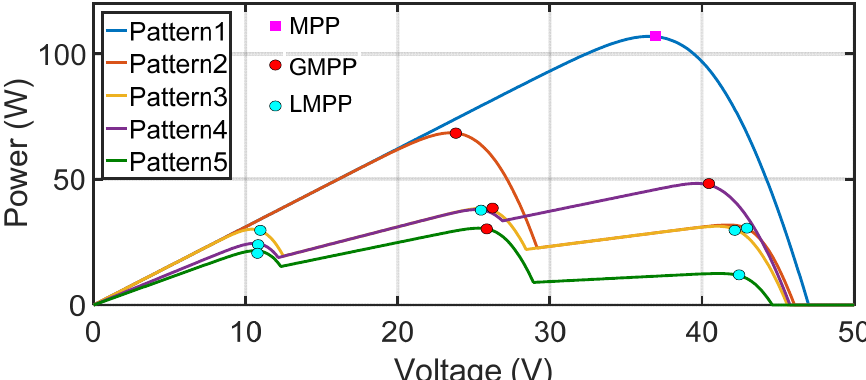
Figure 5. The P ‐ V curves under various shading conditions. Figure 5. The P-V curves under various shading